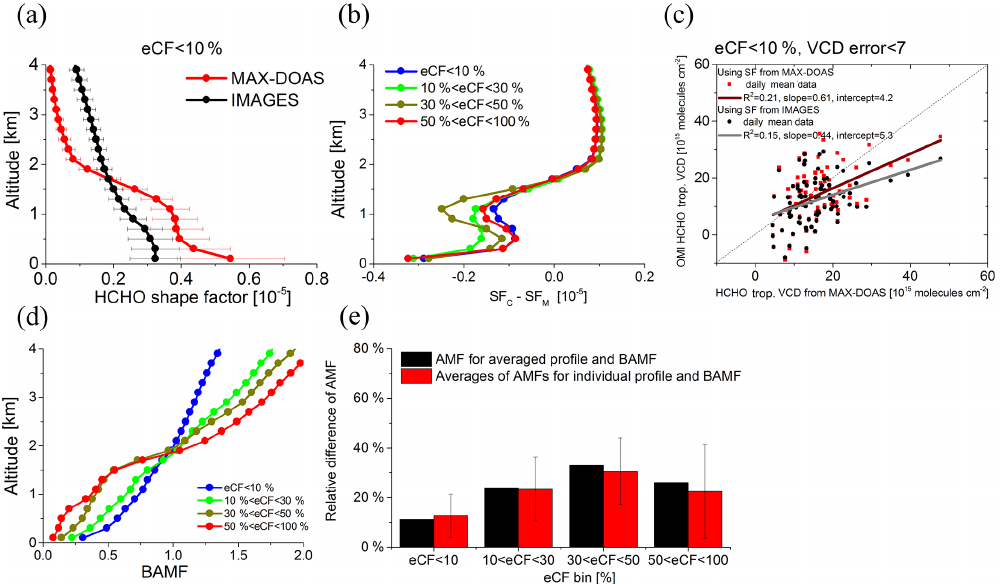
Figure 11. Same as Fig. 9 but for the OMI BIRA HCHO product and eCF bins of 0–10, 10–30, 30–50 and 50–100%. Note that the SF for the OMI BIRA product is obtained from the IMAGES